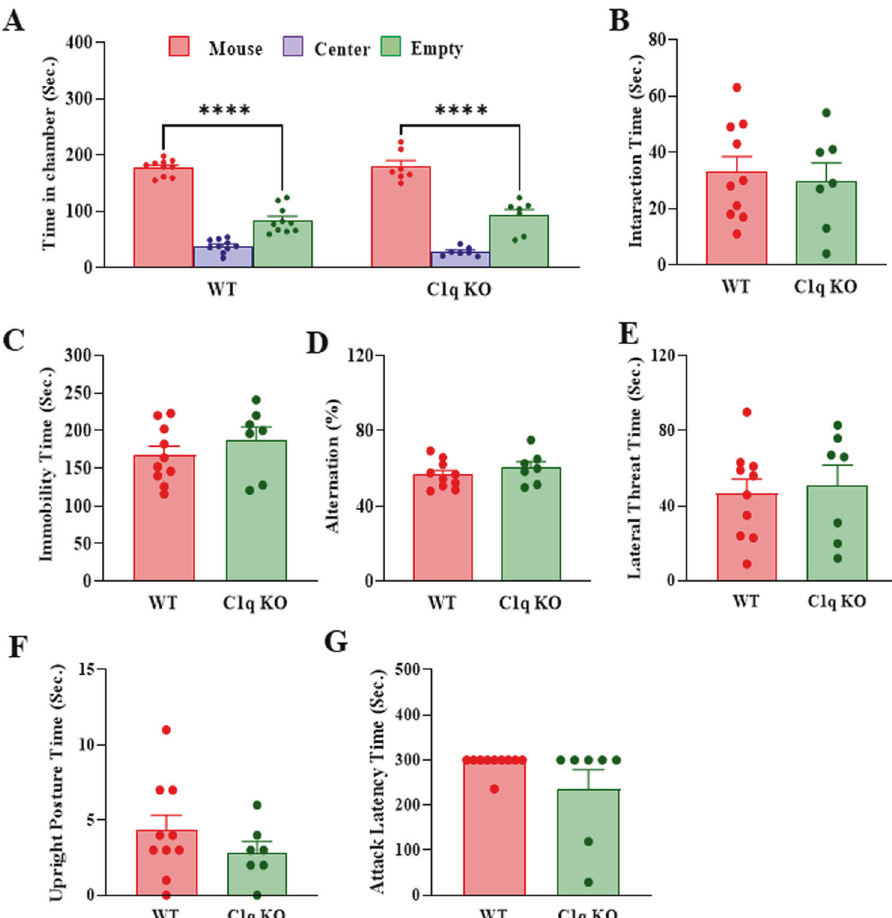
**** p < 0.0001 (mouse chamber vs. empty chamber). B Reciprocal social interaction test. Unpaired t-test, p = 0.7044 vs WT. C Immobility time in tail suspension test. Unpaired t-test, p = 0.3274 vs WT. D Percentage (%) of alternations in Y-maze test. Unpaired t-test, p = 0.3460 vs